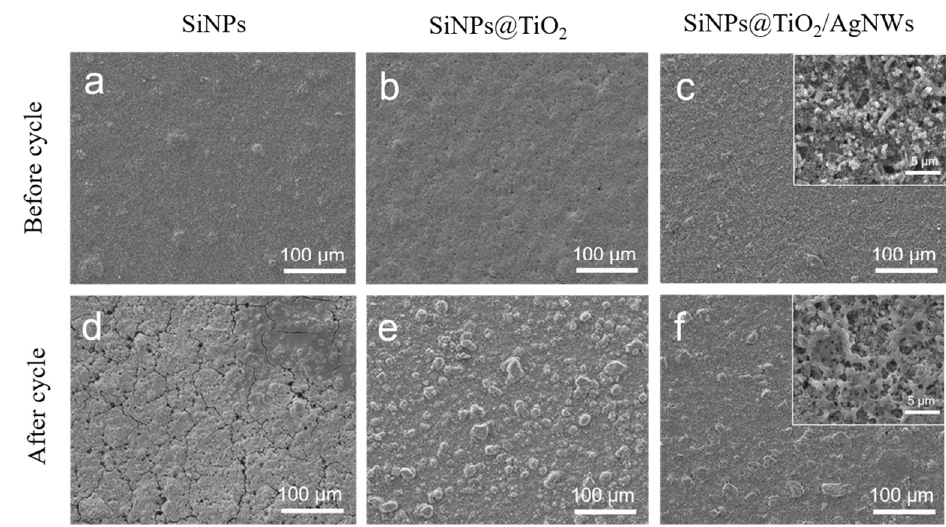
Figure 7. SEM images of the surface of different battery cathode materials before and after 100 cycles of charging and discharging ( a , d ) SiNPs, ( b , e ) SiNPs@TiO 2 , and ( c , f ) SiNPs@TiO 2 /AgNWs.